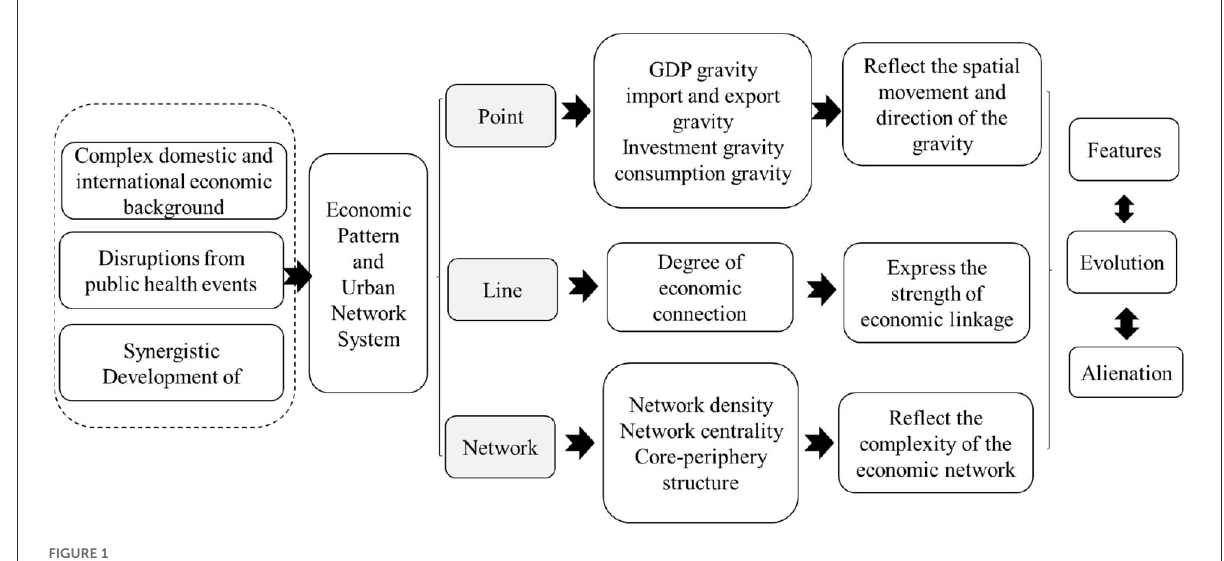
FIGURE1 Methodological